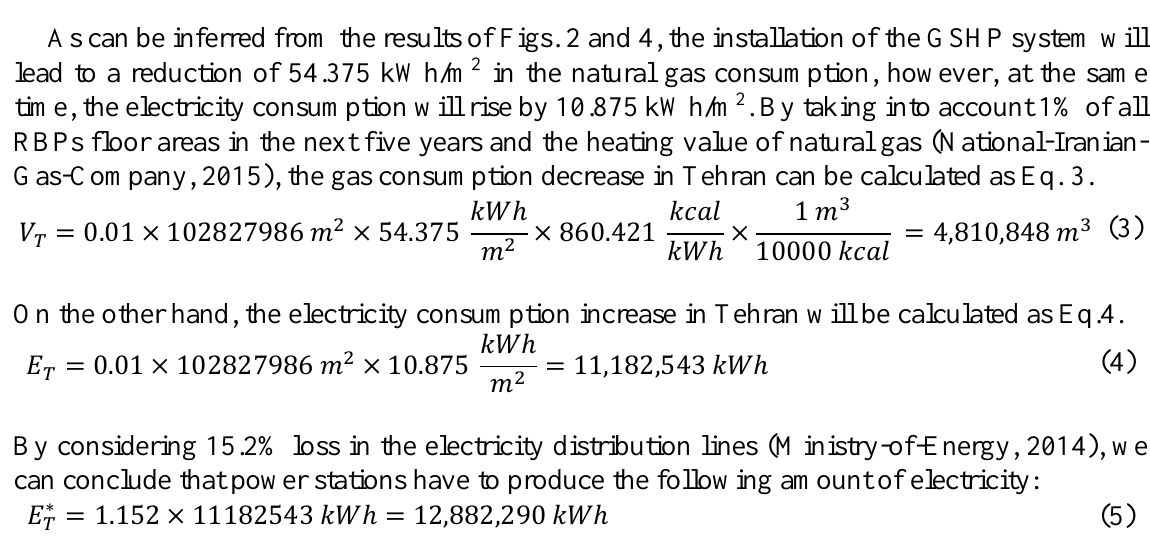
Figure 4 . The energy consumption breakdown during the